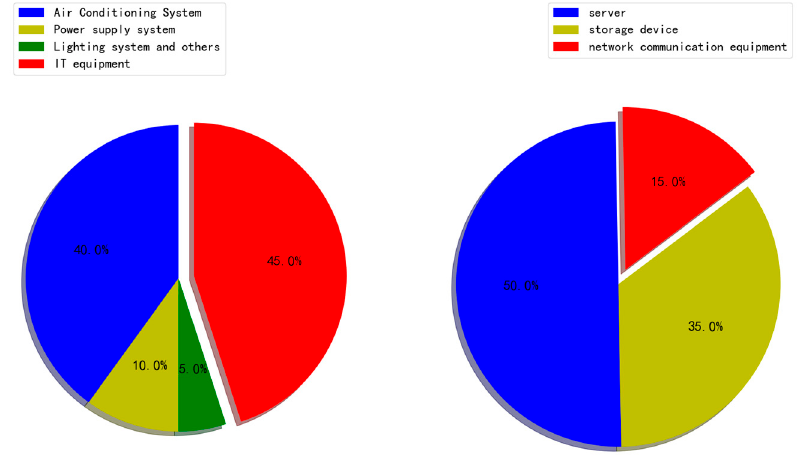
Figure 20. Data Center Energy Consumption Composition.